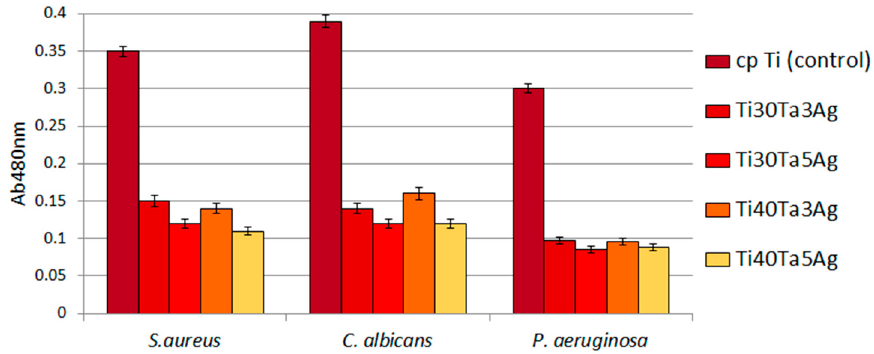
Figure 9. The reduced ability of tested microbes to form biofilm on Ti-Ta-Ag surface.